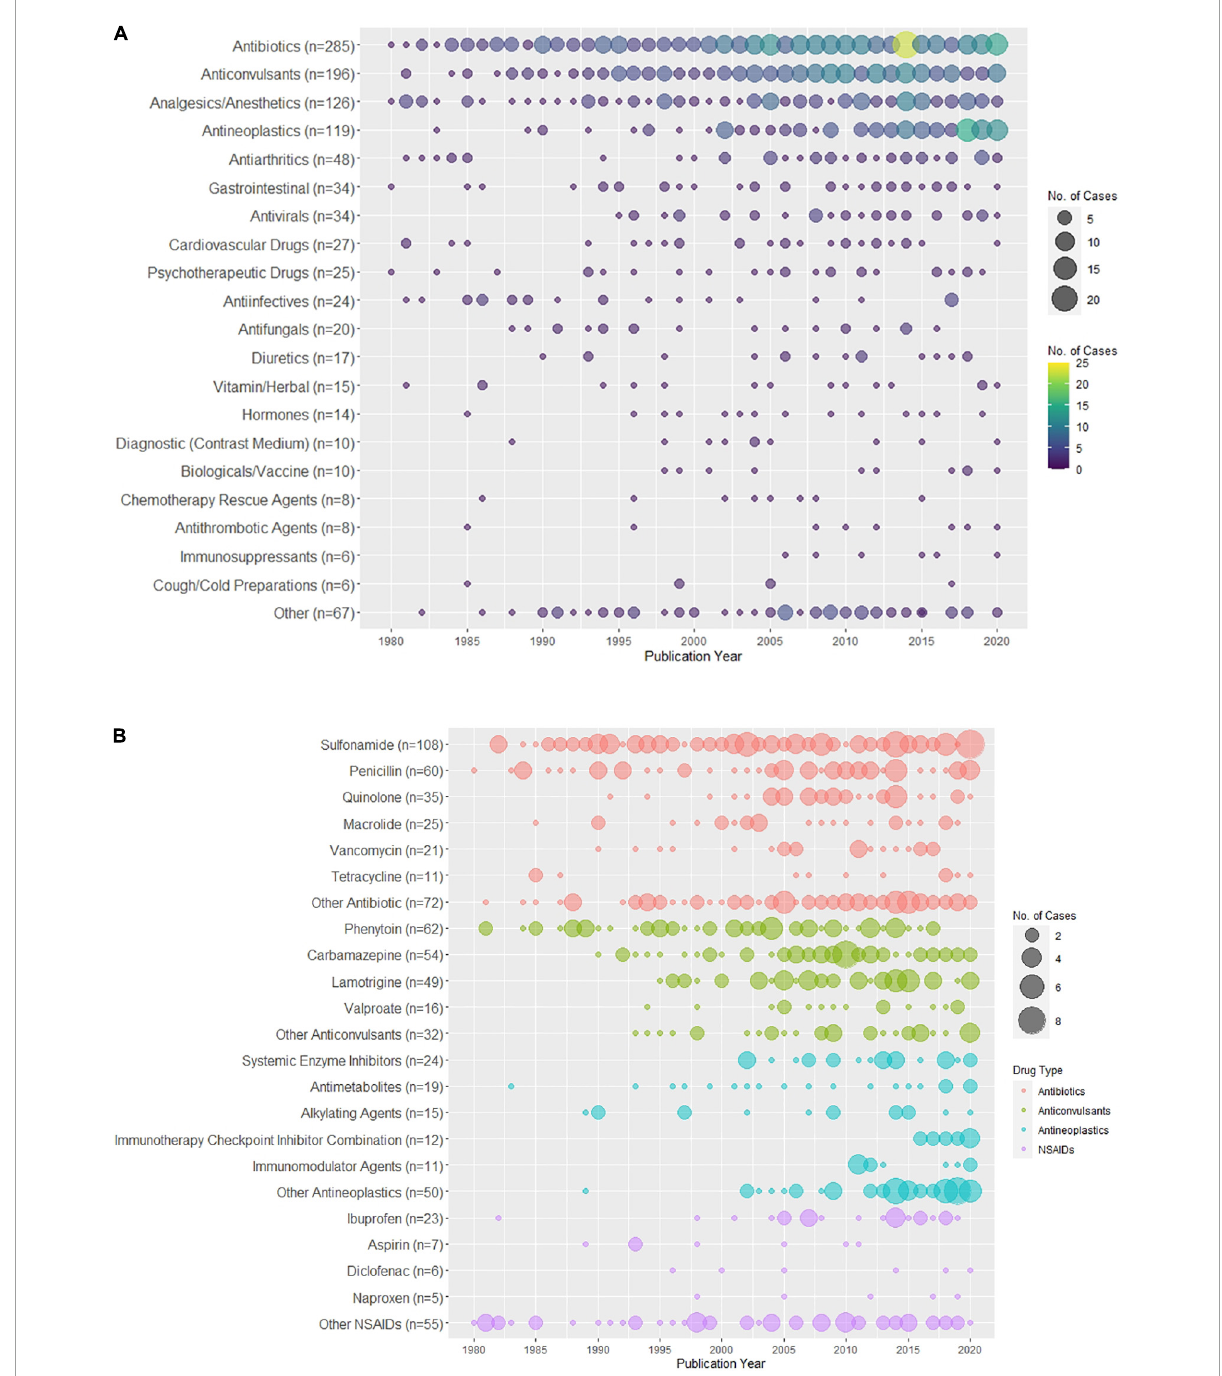
FIGURE4 Distribution of drug culprits over the years. (A) Distribution of the drug categories of the culprit drugs associated with SJS/TEN over the years. (B) Distribution of the culprit drugs of top four common drug categories (antibiotics, anticonvulsants, antineoplastics, non-steroidal anti-inflammatory drugs [NSAIDs]) associated with SJS/TEN over the years.